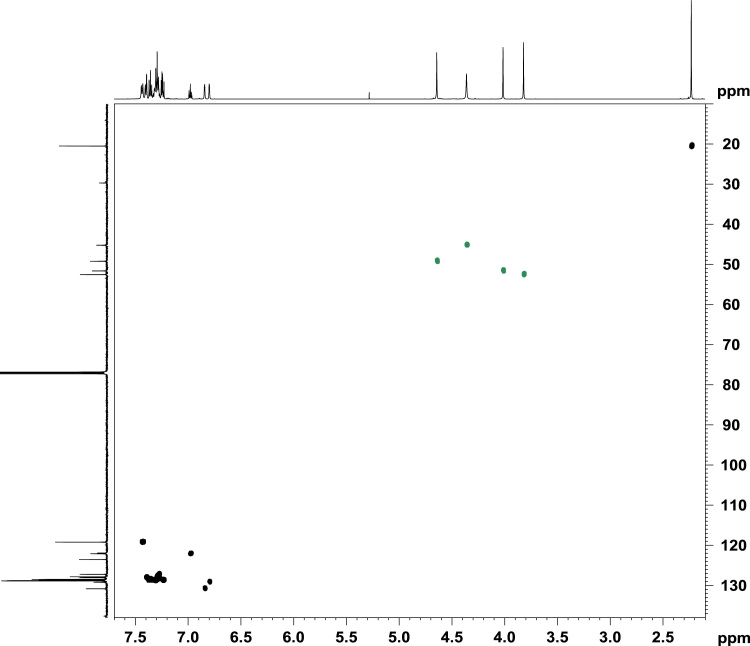
1H-13C HSQC spectrum of ligand S1.